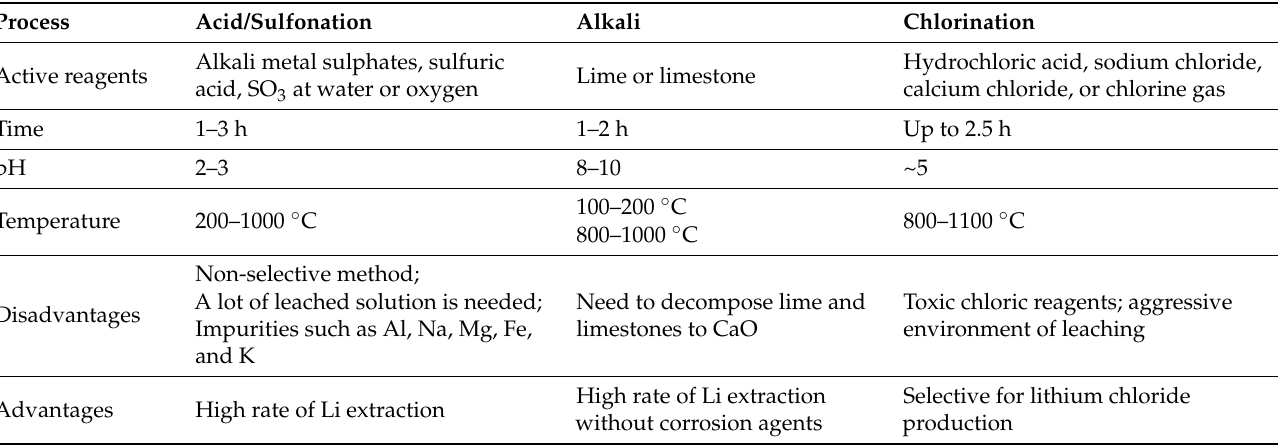
Table 4. Comparison of leaching processes for lithium extraction from minerals